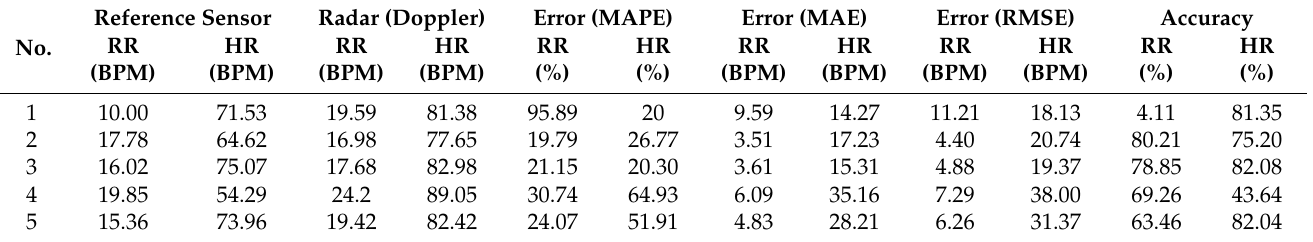
Table 5. The measurement accuracy of respiration and heartrates monitored by the Doppler radar for the case with interferer.